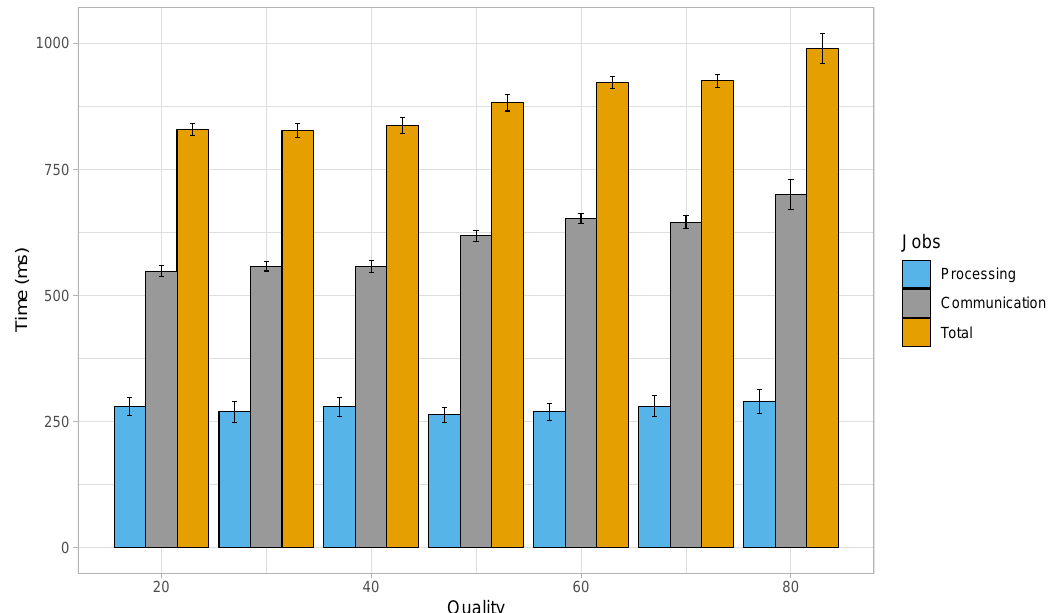
Figure 11. Delay when using a wired network to process images of HD resolution by a cloud